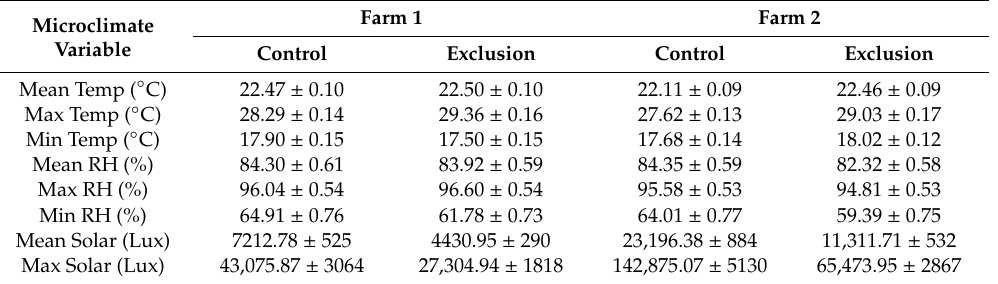
Table 1. Mean (± SE) daily values (mean, maximum, and minimum) for three microclimate variables (temperature, relative humidity, and solar radiation) averaged across two replicate sensors per treatment at two sites on Hawai’i Island from July–December 2018.